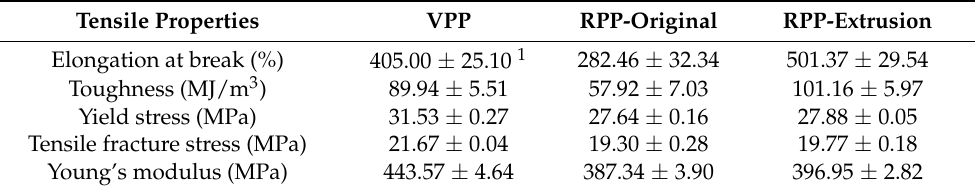
Figure 3. ( a ) Representative stress–strain curve of VPP, RPP-original, and RPP-extrusion; ( b ) Photo image of the elongated specimen after testing by tensile test. Table 2. Tensile properties of VPP, RPP-original, and RPP-extrusion.